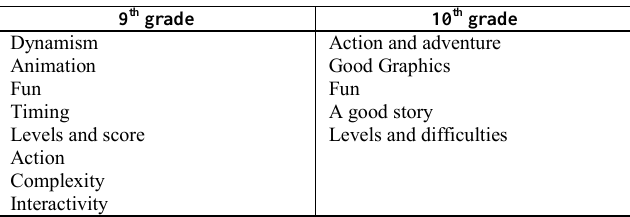
Table 6. Students perceptions of the use of video